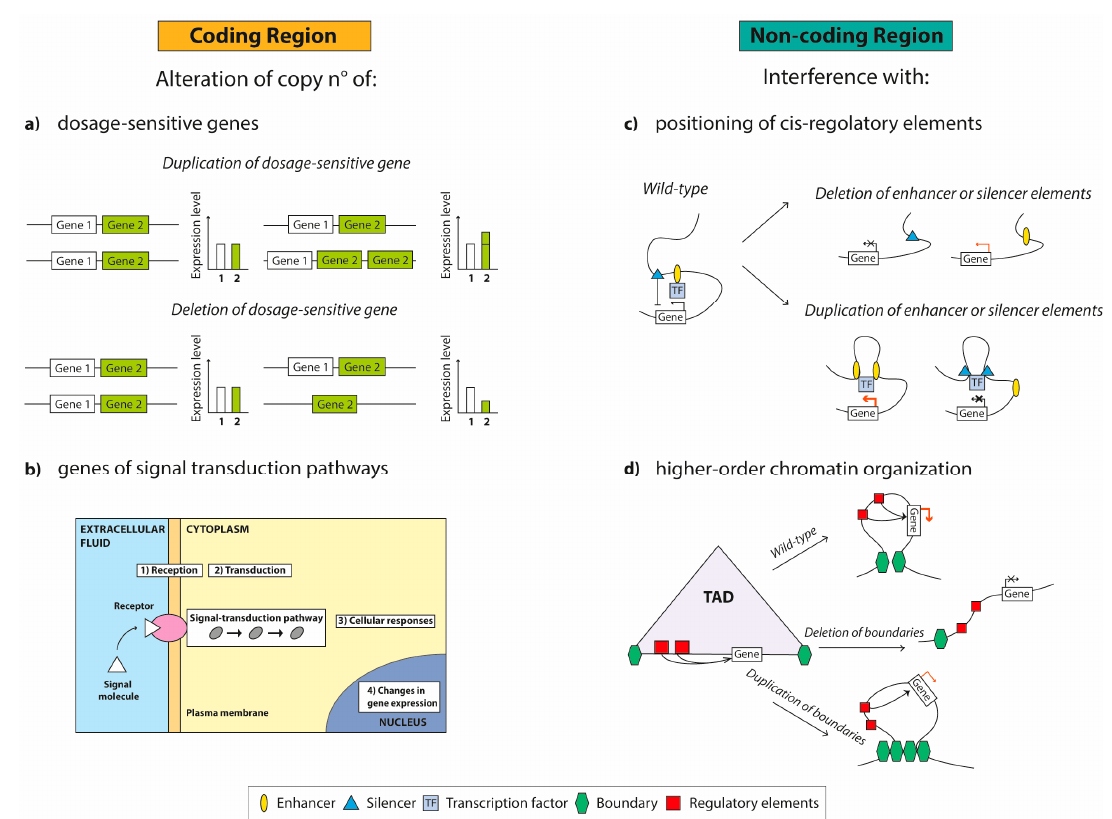
Figure 1. Examples of disease phenotypes caused by the presence of copy number variants (CNVs) in coding and non-coding regions. When localized in coding regions, CNVs could cause an alteration of ( a ) copy number of dosage-sensitive genes (duplications and deletions) or ( b ) genes involved in signal transduction pathways. On the other hand, CNVs in non-coding regions could interfere ( c ) with the positioning of cis -regulatory elements (deletion and duplication of enhancer or silencer elements) and ( d ) with the higher-order chromatin organization such as the structure of topologically associating domains (TADs) (deletion and duplication of boundaries).